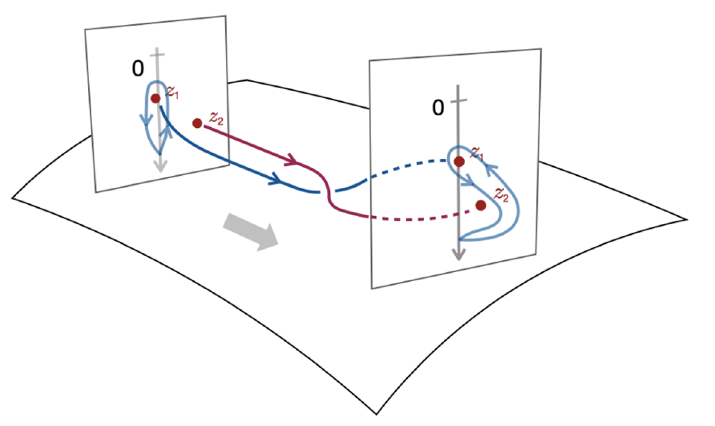
Figure 8 . A braiding de(cid:12)ned by the Knizhnik-Zamolodchikov